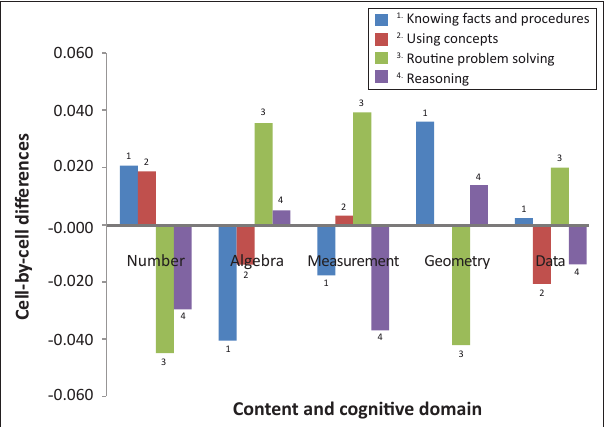
FIGURE 4 : Discrepancies between RNCS and assessment standards and TIMSS 2003 test items. Figure 5: SA learners' performance inTIMSS 2003 compared to the international average